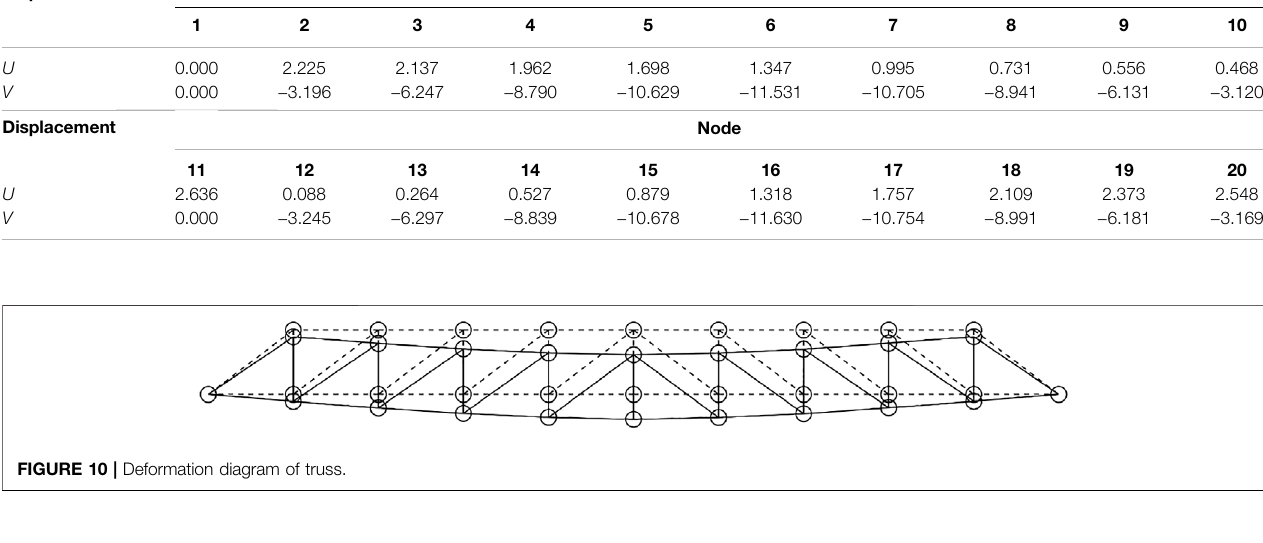
TABLE 7 | Values of force residual vector P